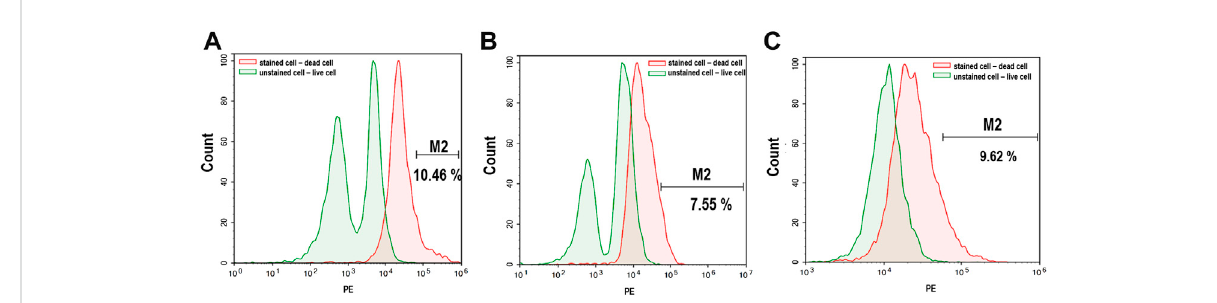
FIGURE 7 In vitro osteogenic differentiation in each group of 1:1 (alginate: quercetin-preloaded HAp) hybrid microspheres. (A) ALP/DNA and (B) calcium/ DNA. (n = 4), * p < 0.05.